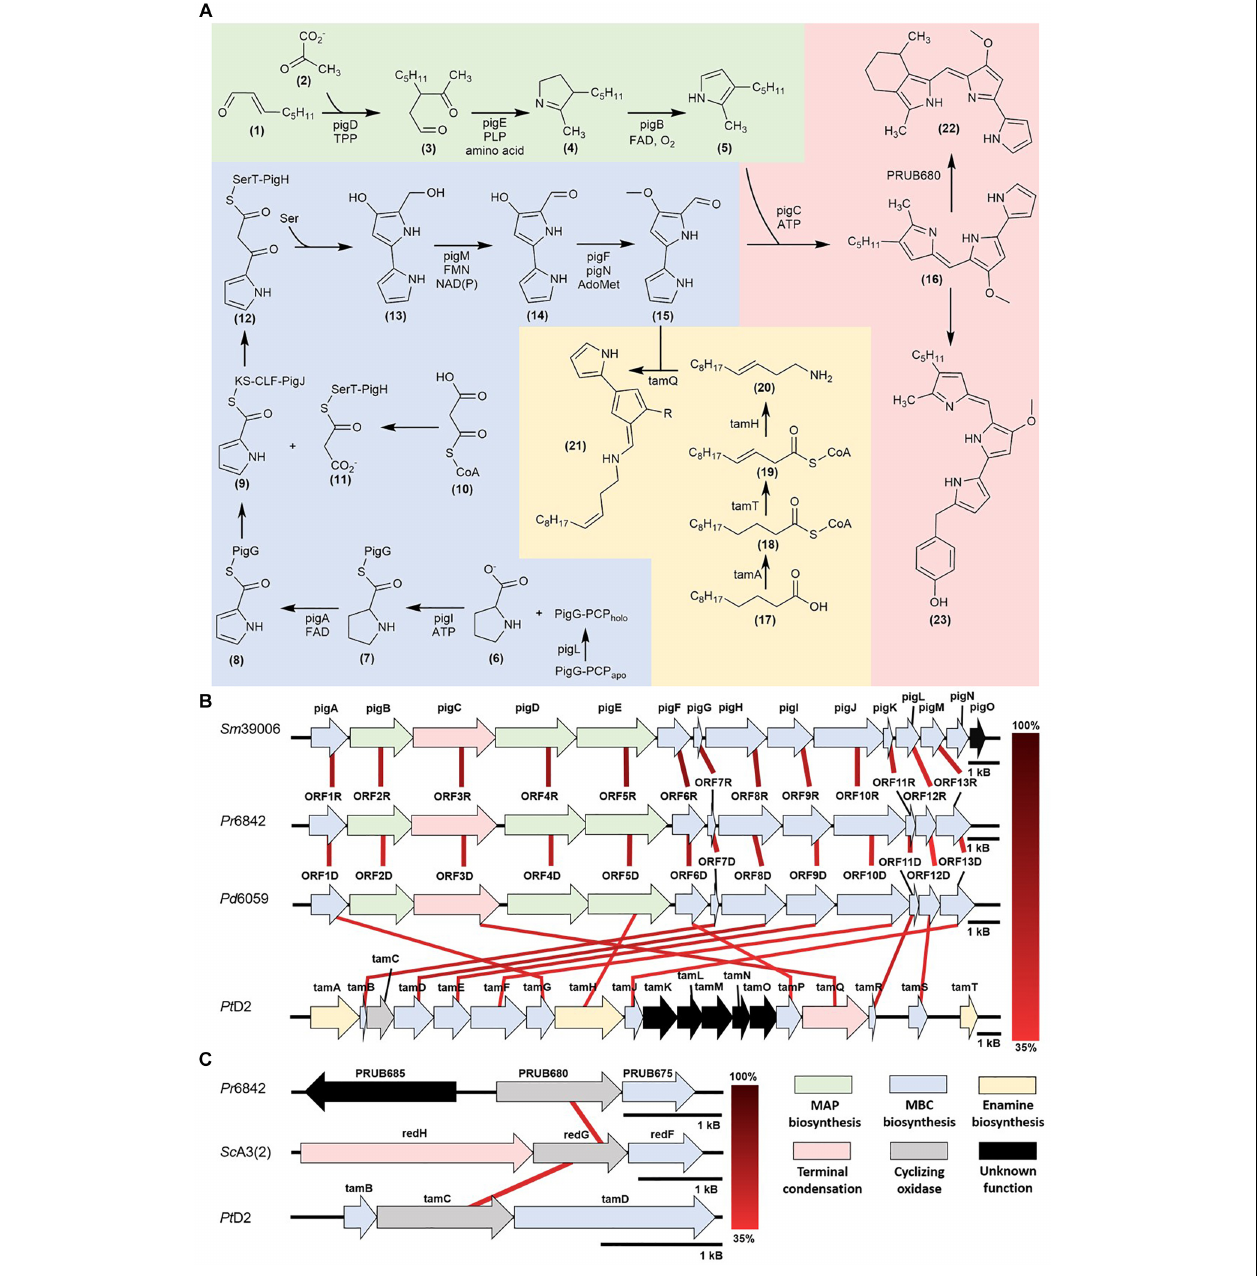
FIGURE 1 | (A) Prodiginine biosynthetic pathways: MAP biosynthesis (green), MBC biosynthesis (blue), prodigiosin, cPrG, and HBPG biosynthesis (red), enamine and tambjamine biosynthesis (yellow) (B) Mapping of homologous prodiginine biosynthetic gene clusters in Serratia marcescens ( Sm 39006), Pseudoalteromonas rubra ( Pr 6842), Pseudoalteromonas denitrificans ( Pd 6059), and Pseudoalteromonas tunicata ( Pt D2). The relationship between pigE and tamH is discussed in the Further insight via functional genomics and DNA manipulation (C) Mapping of homologous cyclizing oxygenases in Streptomyces coelicolor [ Sc A3(2)], Pseudoalteromonas rubra ( Pr 6842) and Pseudoalteromonas tunicata ( Pt